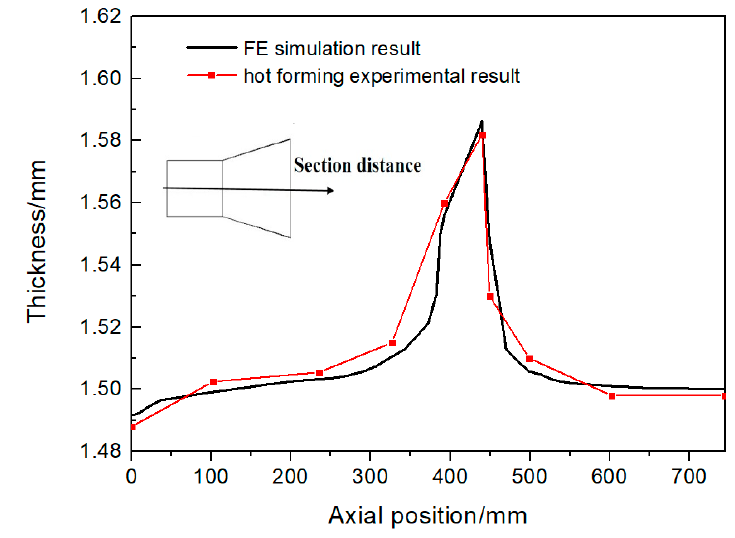
Figure 14. Thickness variation along the center axis of hot formed workpiece using two-step forming scheme.